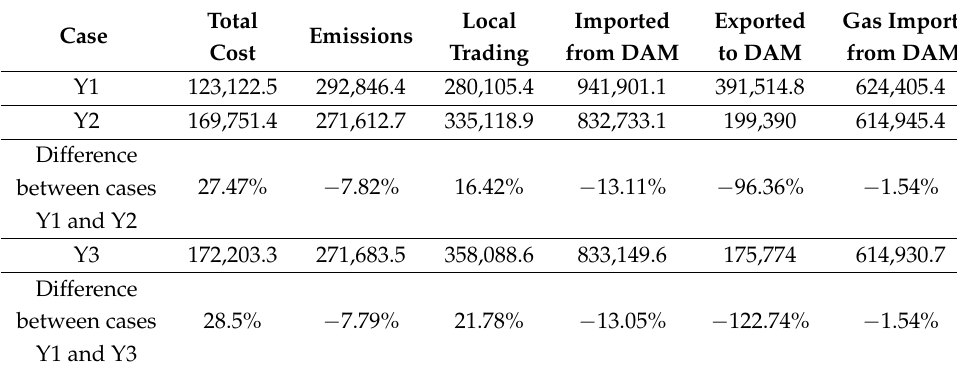
Table 6. The results for yearly analyses Y1, Y2 and Y3.